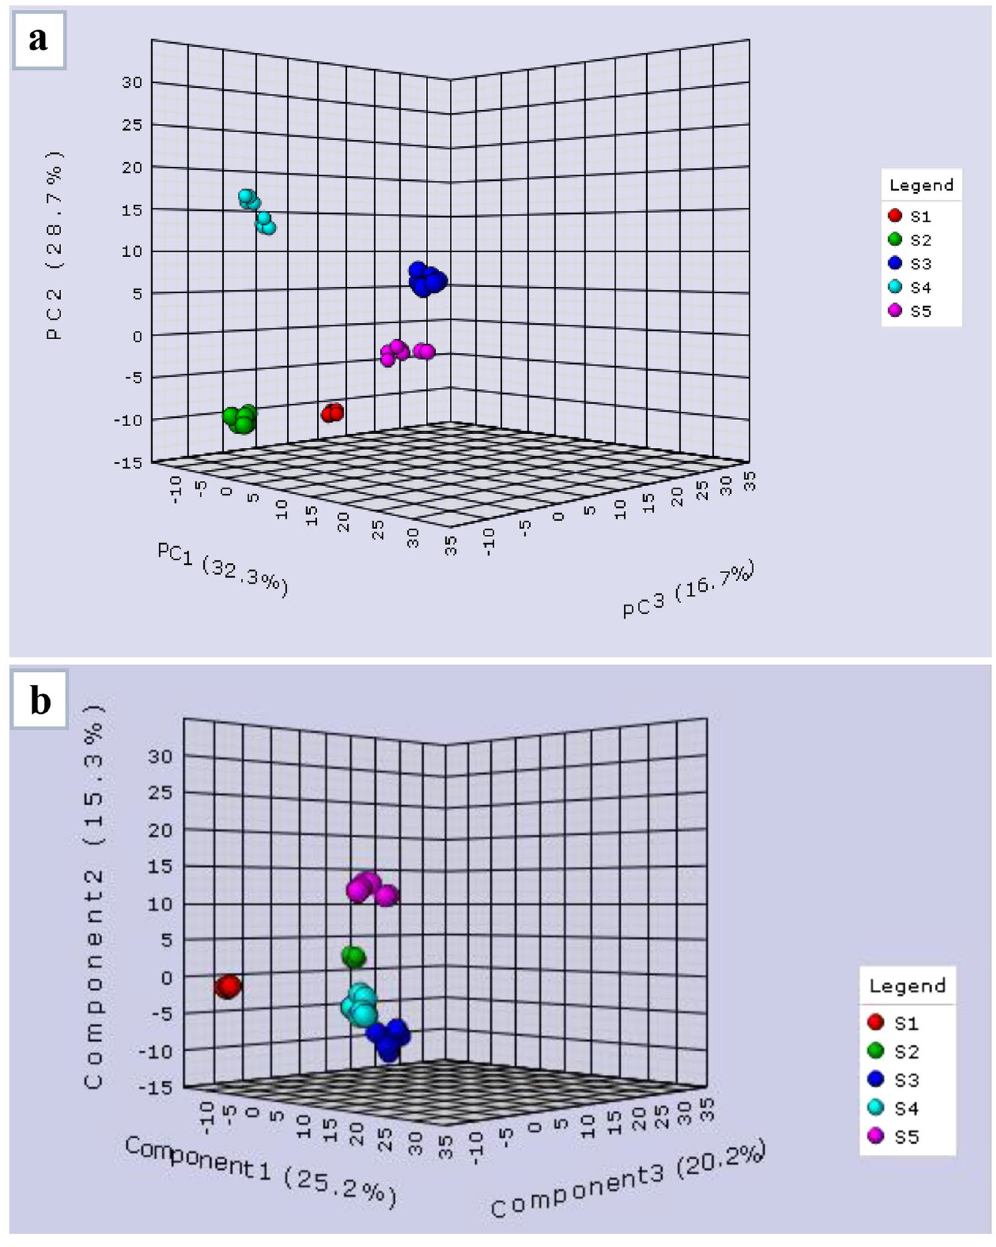
Figure 2. ( a ) Principle component analysis (PCA) of metabolite profiles of distinct developmental stages of Corm (S1-S5) during dormancy and sprouting process. PCA presented as combination of first three dimensions, which together comprise 78.7% of the metabolite variance. ( b ) Partial least square-discrimination analysis (PLS-DA) of metabolite profiles of distinct developmental stages (S1–S5) during dormancy and sprouting process. PLS-DA presented as combination of first three dimensions, which together comprise 60.7% of the metabolite variance. A web-based tool MetaboAnalyst 2.0 was used to analyse the data. The separate percentages of the variance for each plot are given in brackets in each